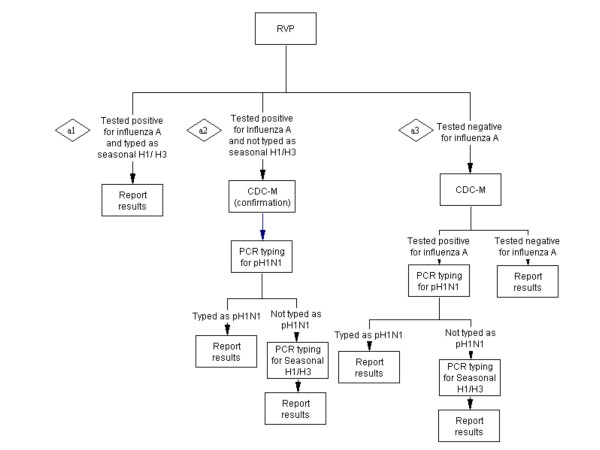
Scenario A - RVP with/without CDC-M.